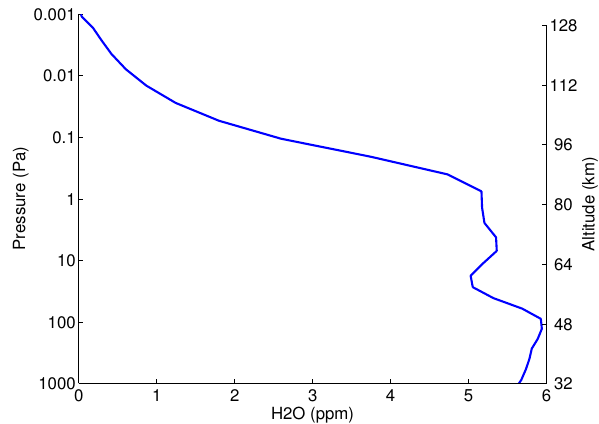
Figure 2. The H 2 O a priori profile created from the mean of a MLS